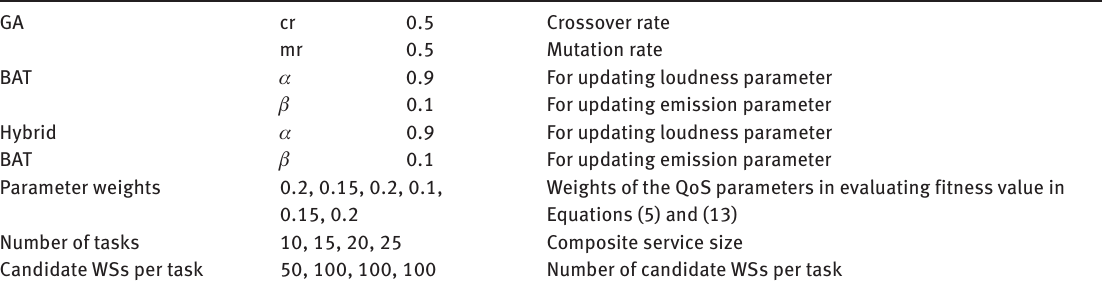
Table 3: Simulation